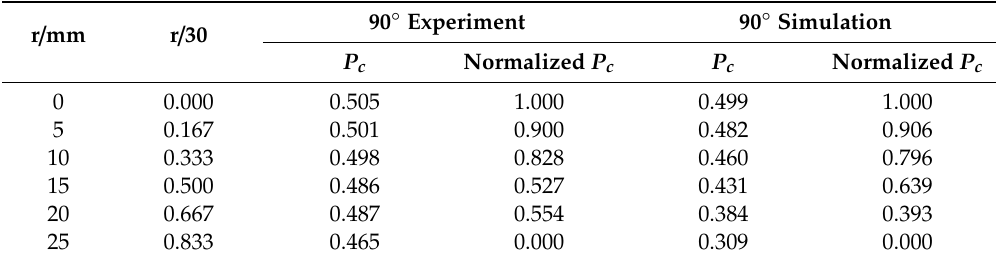
Figure 11. The measured and simulated relative proportion of the capacitance between E2 and E3 ( P c ). Table 6. The normalized P c of the experiment and